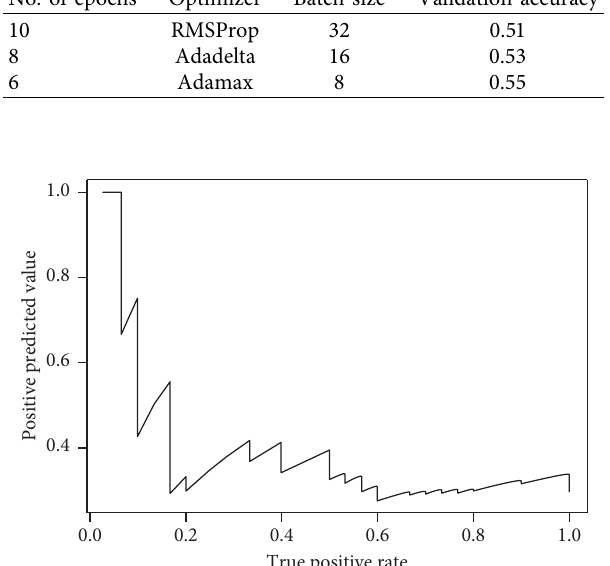
Figure 3: Graph showing AUC curve with the score of 56.83%.